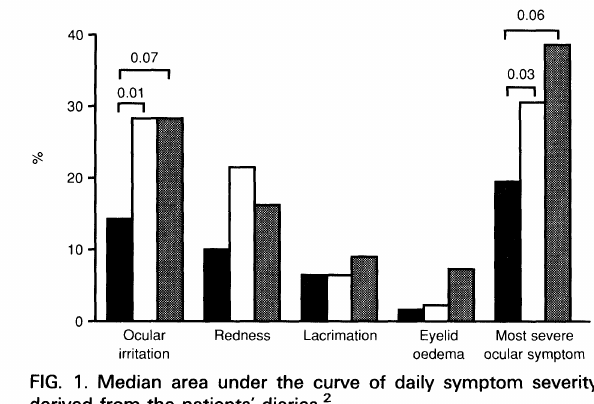
FIG. 1. Median area under the curve of daily symptom severity derived from the patients" diaries. 2